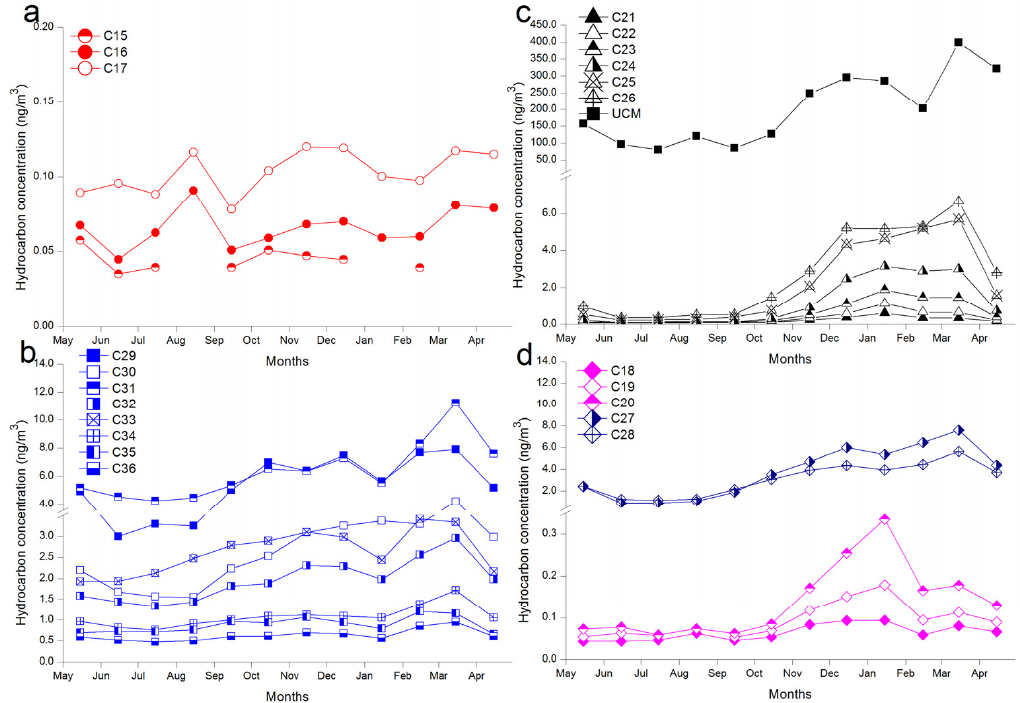
Figure 3. Temporal variations in individual hydrocarbon concentrations of ambient air aerosols in south coastal Xiame. ( a ) short-chain homologs; ( b ) long-chain homologs; ( c ) middle-chain homologs plus unresolved complex matters (UCM); and ( d ) mixture-chain homolgs.